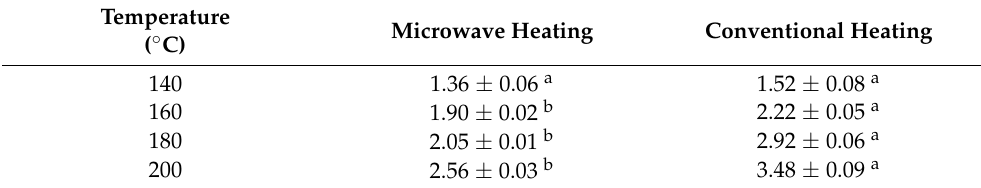
Figure 2. Temperature evolution in PHW extraction of A. chilensis leaves using ( a ) microwave and ( b ) conventional heating, operating at 140, 160, 180, and 200 °C. Table 2. Severity values for different temperatures using microwave and conventional heating in PHWE.